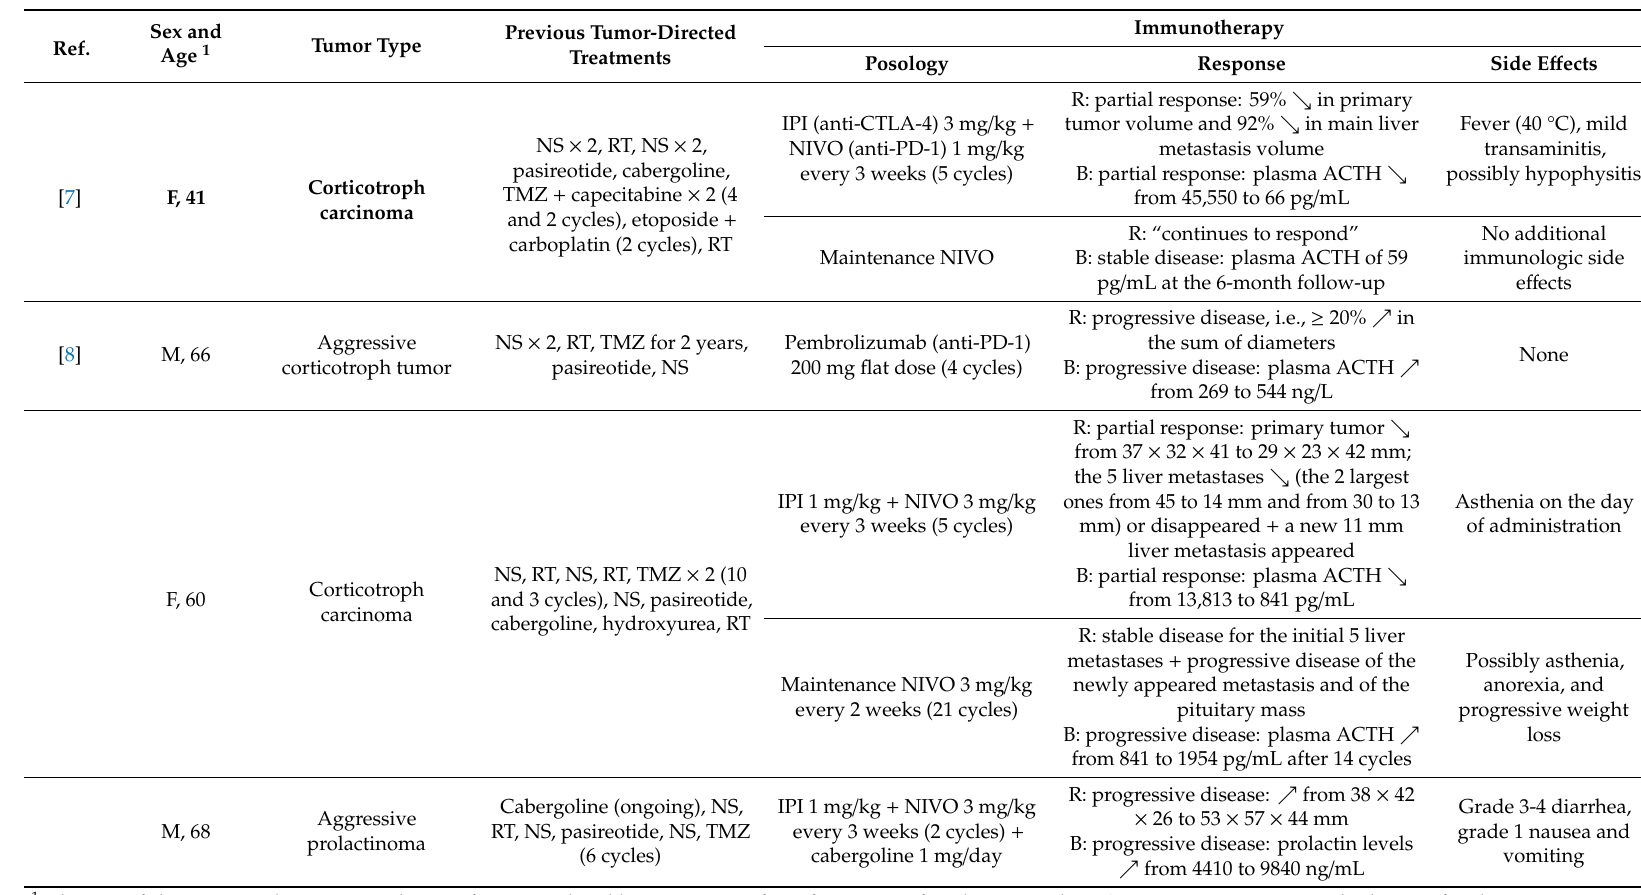
Table 1. Cases of pituitary carcinomas and aggressive pituitary neuroendocrine tumors treated with immunotherapy.